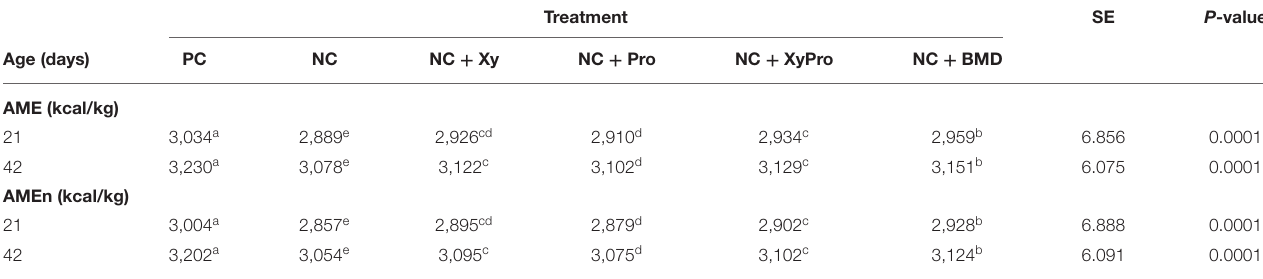
TABLE 3 | Least-square means for apparent metabolizable energy corrected for nitrogen (AMEn) of broilers raised to 42 days. Treatment SE P